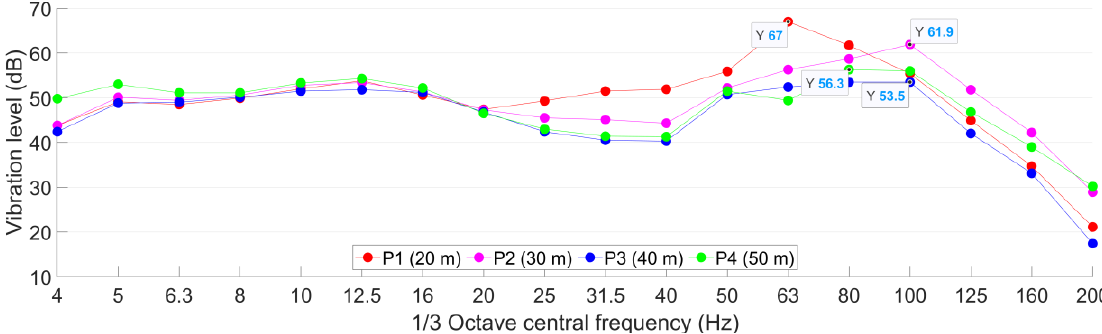
Figure 9. Ground 1/3 octave frequency division vibration acceleration level of the Line A close tunnel in different test points P1 – P4.